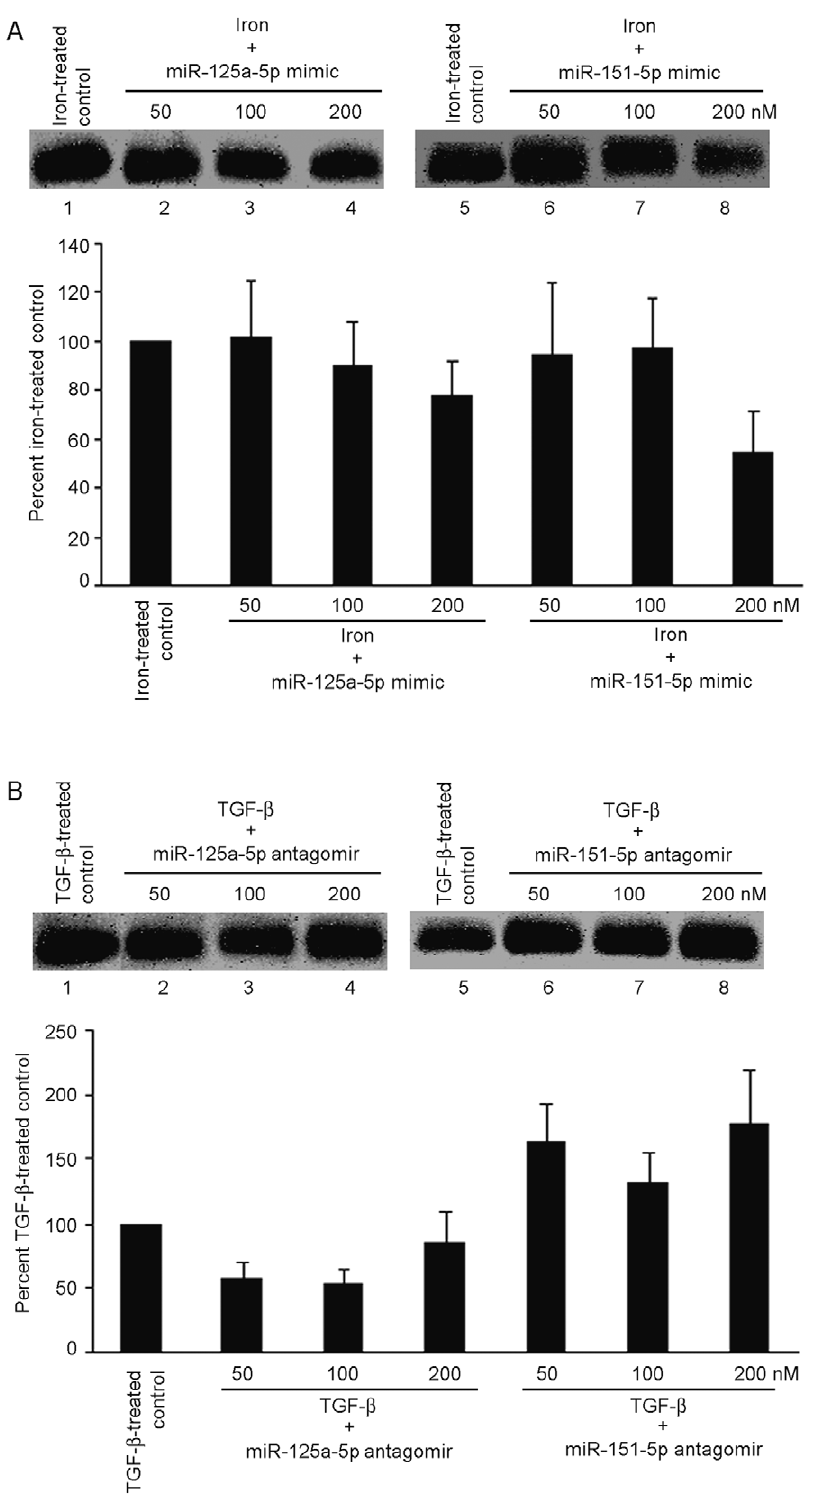
Figure 4. Regulation of HBV replication by agarose gel analysis in cells treated with miRNA. For these studies, 2.2.15 cells were transfected with miRNA mimics or miRNA antagonists followed by administration to transduced cells of either 20 ng/ml TGF- b or 100 m M iron for 48 h. (A) Changes in iron-treated cells are shown after expression of miR-125a-5p or -151-5p mimics. These mimics dose-dependently decreased HBV replication in iron-treated cells. (B) Changes in TGF- b -treated cells are shown after expression of miR-125a-5p and miR-151-5p antagonists. These antagonists dose-dependently reversed TGF- b -induced inhibition of HBV replication. This substantiated the role of intracellular miRNA in regulation of HBV replication by iron or TGF- b .